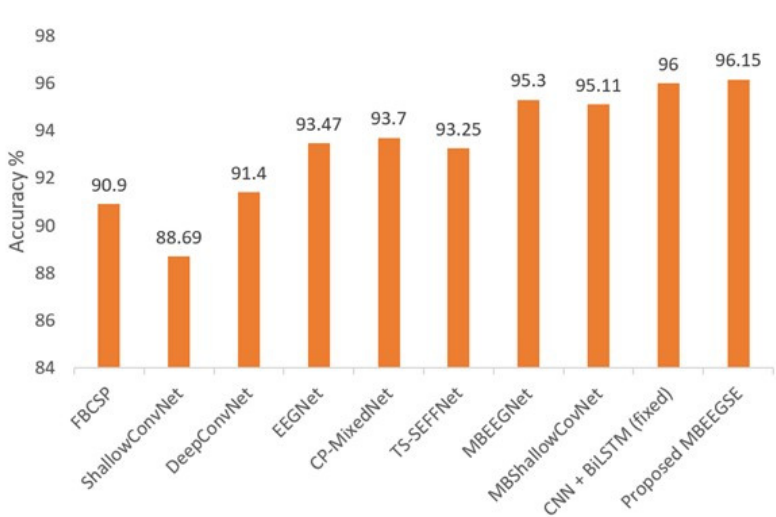
Figure 7. Average classification accuracy on the HGD.